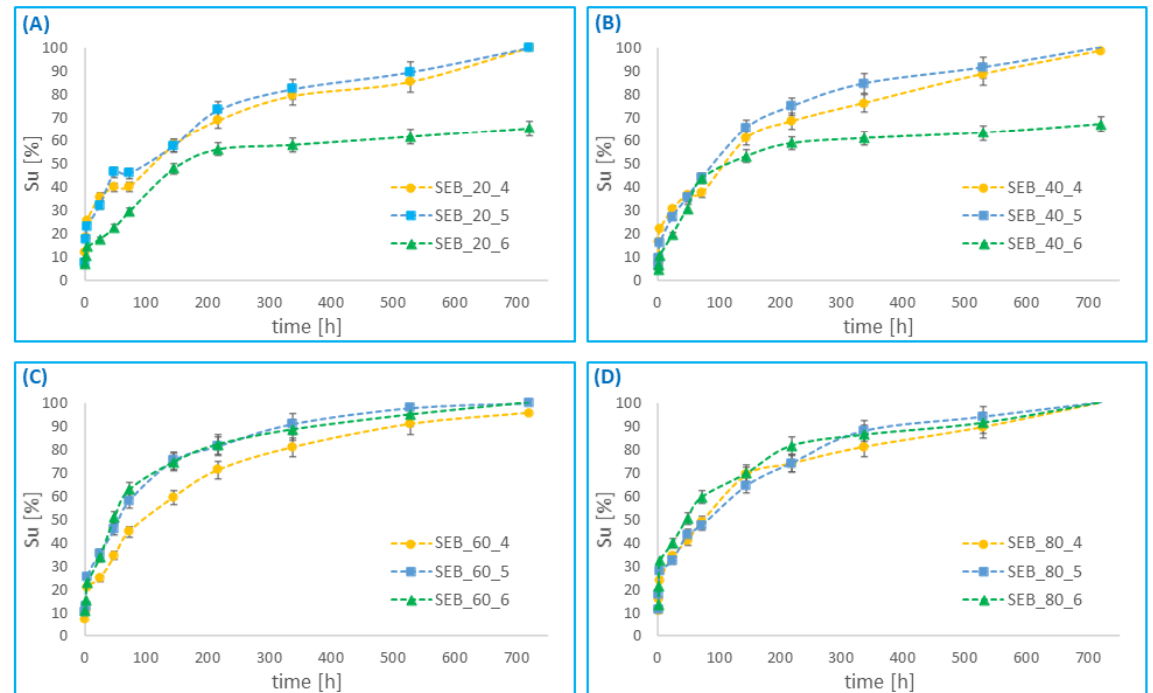
Figure 12. Cumulative release of rifampicin from small microspheres, obtained from: DBB_SEB_20 ( A ), DBB_SEB_40 ( B ), DBB_SEB_60 ( C ) and DBB_SEB_80 ( D ), as a function of time.